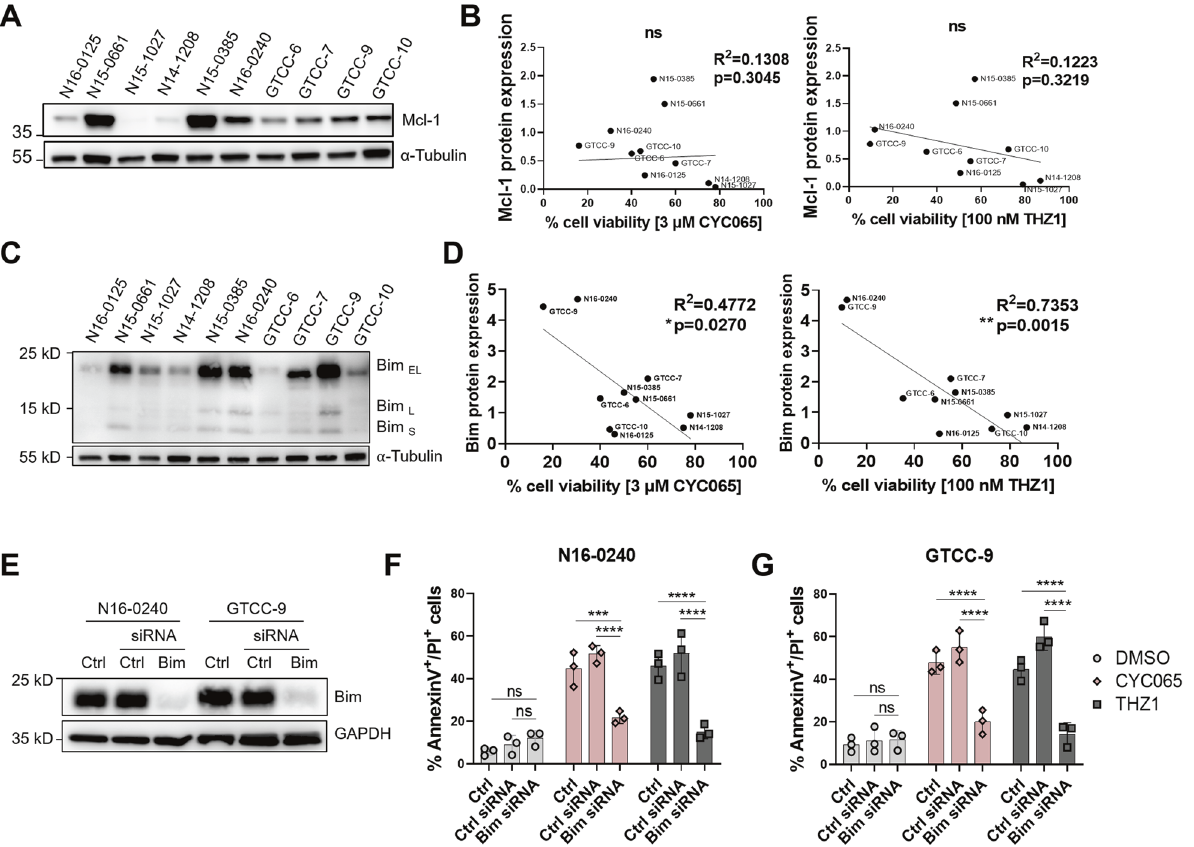
Fig. 4 Downregulation of Mcl-1 triggers Bim-dependent apoptosis in sensitive gliomasphere cultures. A Whole-cell lysates from ten patient-derived gliomasphere cultures were used to determine Mcl-1 protein expression. α -Tubulin was used as a loading control. Western blot analysis is performed in n = 3 biological replicates and representative blots are shown here. B Correlation analysis of Mcl-1 basal protein expression in gliomaspheres and treatment response to 3 μ M CYC065 (left panel) and 100 nM THZ1 (right panel) was done using Pearson correlation coef fi cient. N = 3 independent experiments were performed. C Whole-cell lysates from ten patient-derived gliomasphere cultures were used to determine Bim protein expression. α -Tubulin was used as a loading control. Western blot analysis is performed in n = 3 biological replicates and representative blots are shown here. D Correlation analysis between Bim basal protein expression in gliomaspheres and treatment response to 3 μ M CYC065 (left panel) and 100 nM THZ1 (right panel) were calculated using Pearson correlation coef fi cient. N = 3 independent experiments were performed. E N16-0240 and GTCC-9 cultures were transfected with scrambled control siRNA (30 nM) and Bim- targeting siRNA (30 nM) for 48 h. Transfection ef fi ciency was assessed by Western blotting and GAPDH was used as a loading control. Western blot analysis was performed in n = 3 biological replicates and representative blots are shown here. F , G Flow cytometry was used to assess the number of AnnexinV + /PI + cell in cultures transfected scrambled control siRNA (30 nM) and Bim-targeting siRNA (30 nM) for 48 h and following 24 h treatment with DMSO, 3 μ M CYC065 or 100 nM THZ1 in N16-0240 ( D ) and GTCC-9 ( E ) gliomaspheres. Data are expressed as mean ± SEM. Two-way ANOVA with post-hoc Tukey ’ s analysis was used for statistical analysis, whereby, *** p < 0.001, **** p < 0.0001, ns = not signi fi cant; n